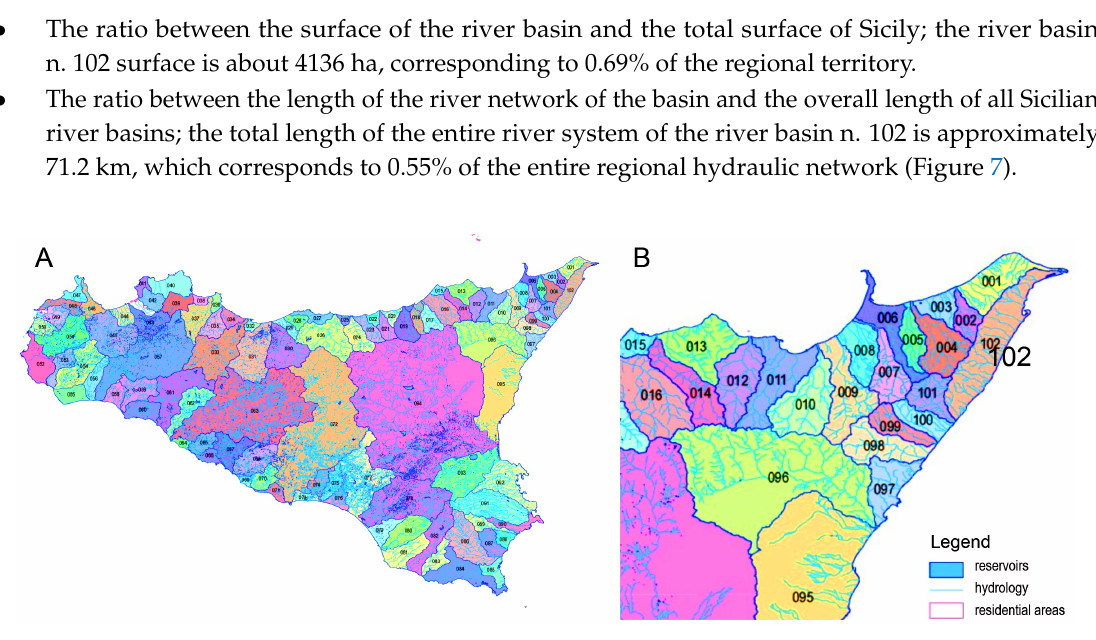
Figure 7. Hydraulic Regional framework ( A ) and detail of the Province of Messina displaying the Fiumedinisi river basin n. 102 ( B